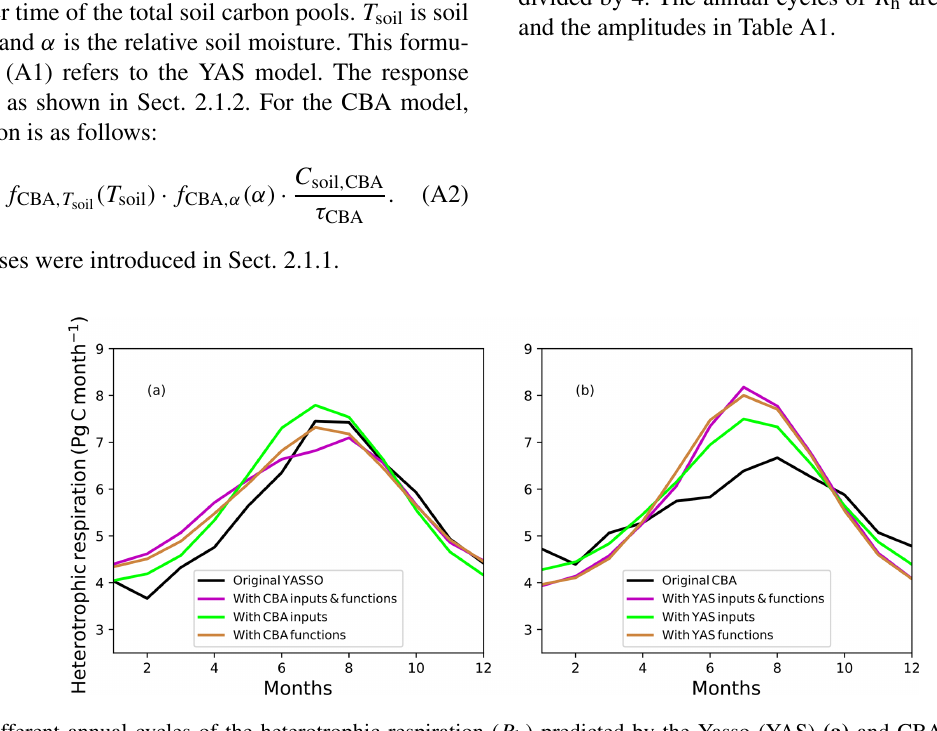
Figure A1. Different annual cycles of the heterotrophic respiration ( R h ) predicted by the Yasso (YAS) (a) and CBALANCE (CBA) (b) model and the different alternatives from the box model